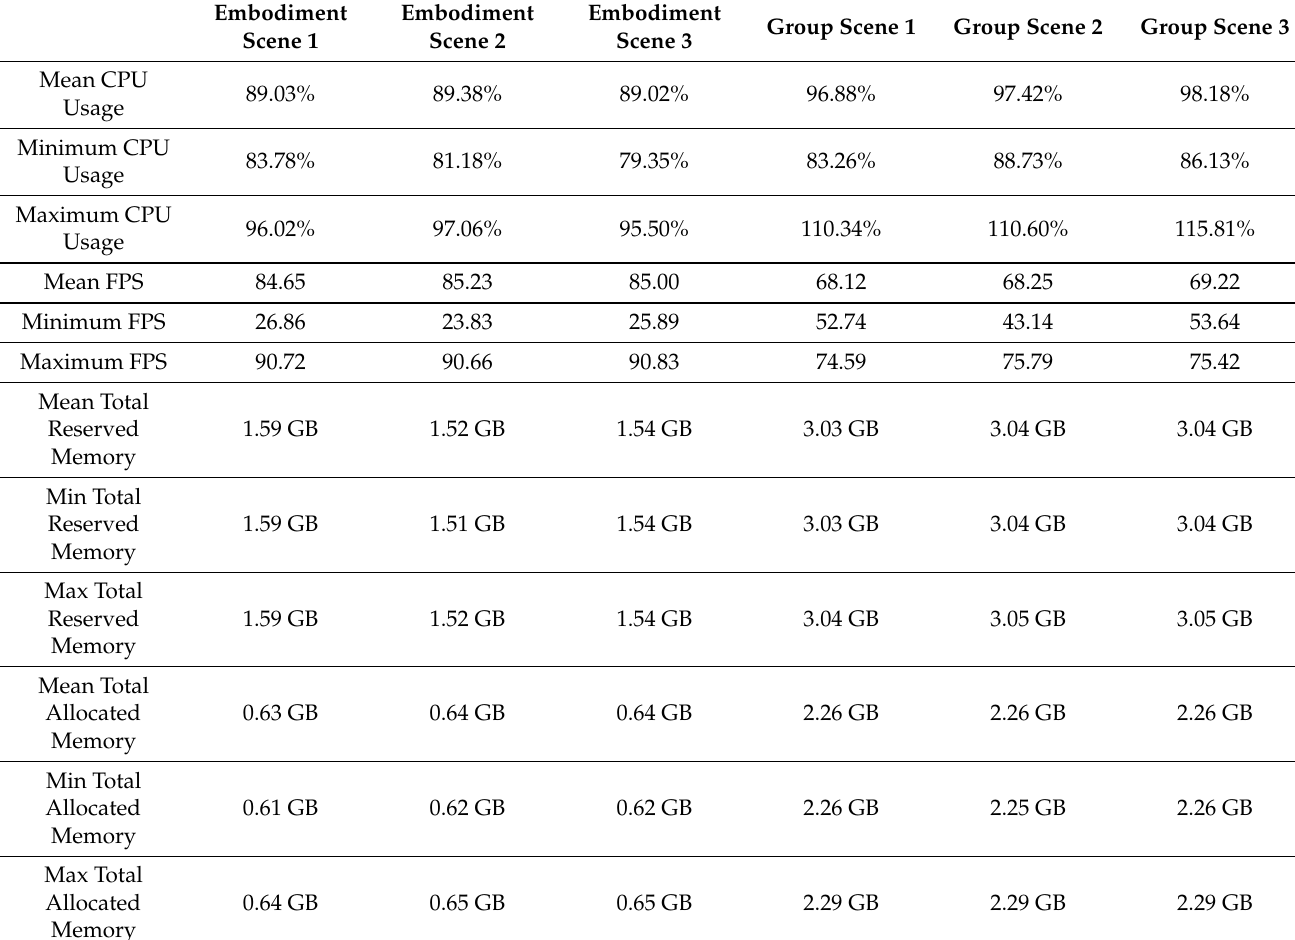
Table A11. Results for Test Condition 6: All sensors.